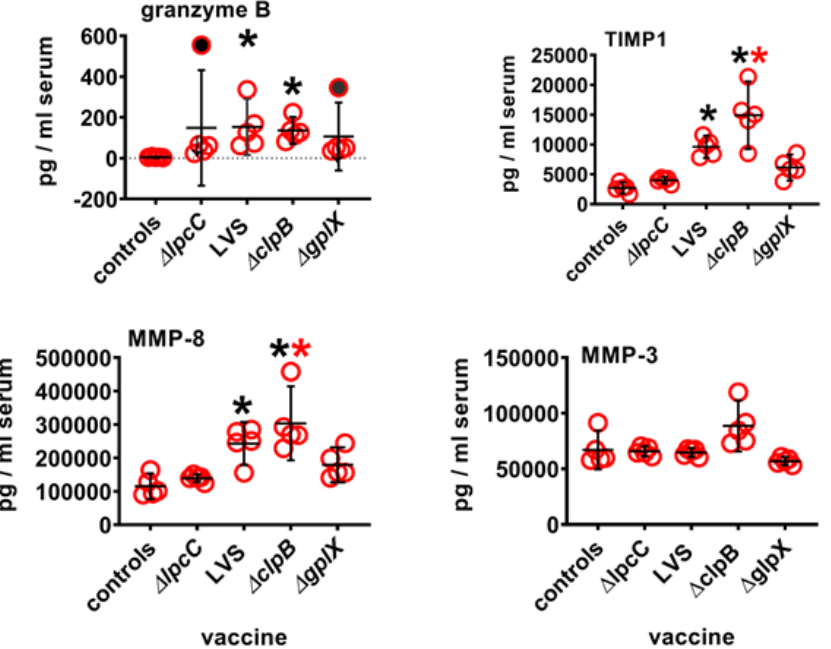
Figure 4. Serum protein levels four days after immunization. Mice ( n = 4–5/group) were immunized ID with 10 5 CFU of one or other vaccine strain. Four days later serum was prepared from each mouse and assayed for the presence of Granzyme B, TIMP1, MMP3, and MMP8. Data were analysed using Kruskal Wallis test to compare each group to every other group followed by Dunn’s correction for multiple comparisons. Filled circles (outliers by ROUT analysis) removed prior to calculations. Black asterisks, significantly greater than levels found in control serum, red asterisks significantly greater than ∆ lpcC (adjusted p ≤ 0.04); 95% CI (vertical black lines) and means (horizontal black lines).